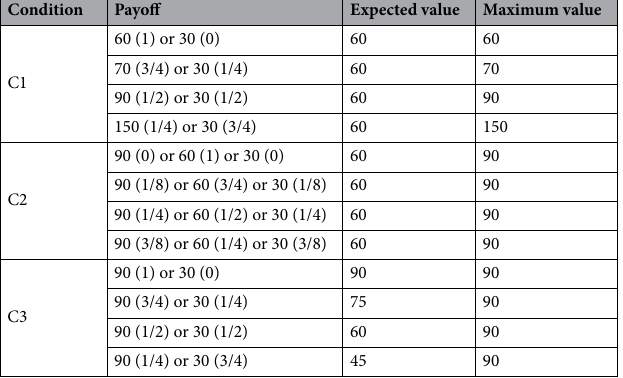
Table 1. Payoffs in each condition. Numbers in parentheses signifying probability of each